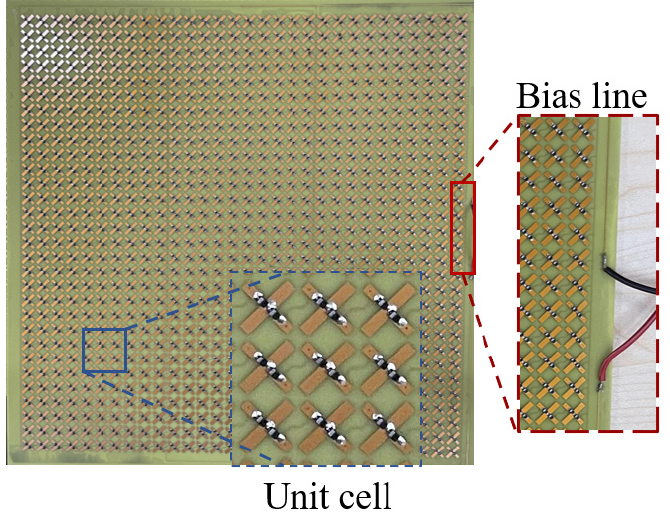
Figure 7. Photograph of the polarization converter sample and bias line.